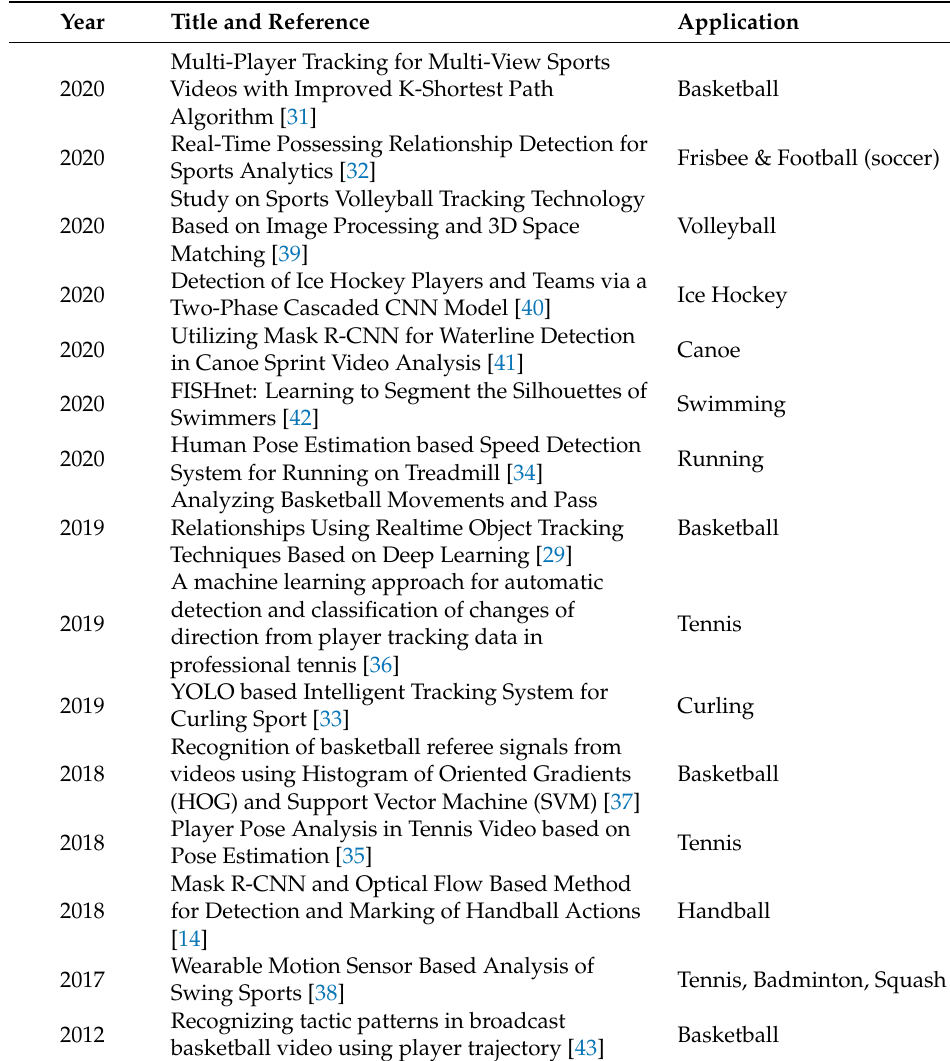
Table 1. Related work regarding applications of machine learning in